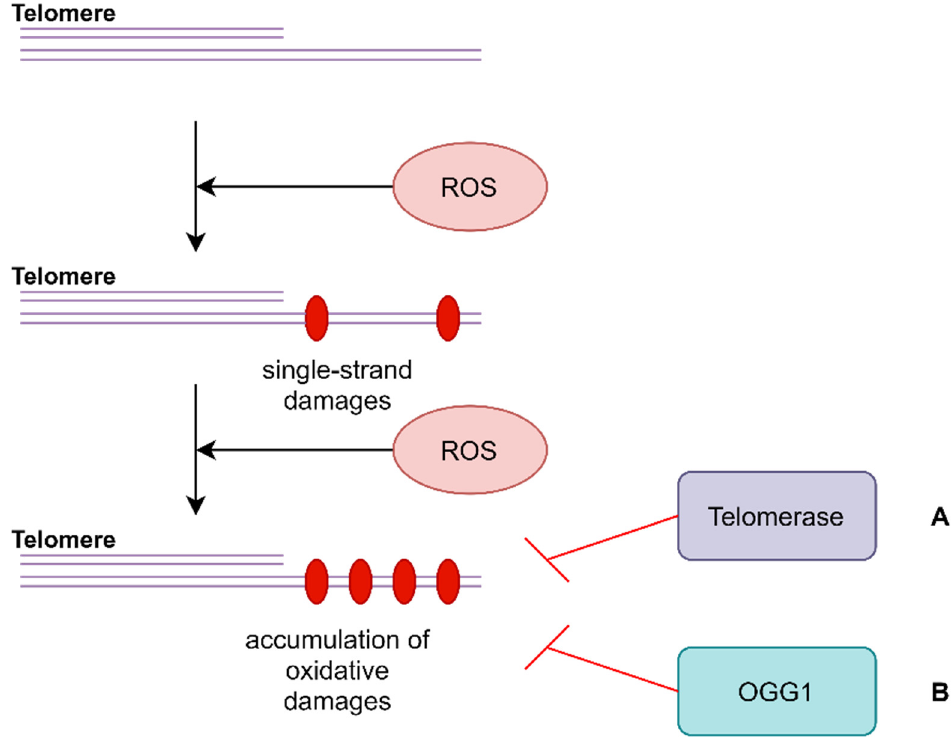
Figure 1. Oxidative telomere damage or single-strand telomere damage prevents the binding of telomer- ase and OGG1. Accumulation of oxidative damage on single-strand fragments of telomeres causes a con- formation change of the end of chromosome so it cannot be recognized by telomerase ( A ). OGG1 cannot repair damage on single strand fragments of telomere because it does not have any template for DNA synthesis ( B ). OGG1–8–oxoguanine DNA glycosylase; ROS–reactive oxygen